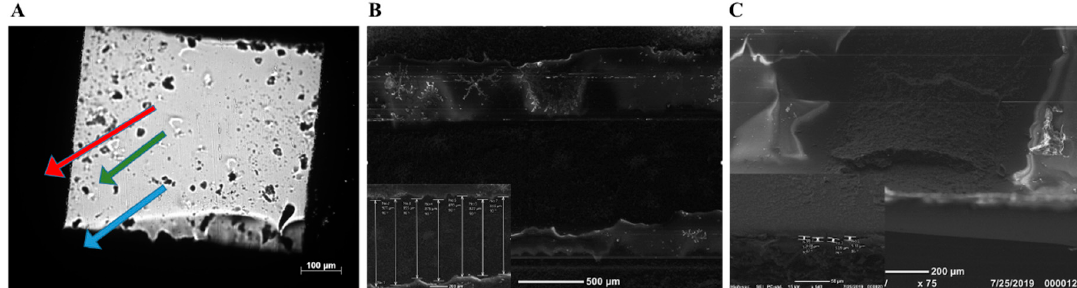
Figure 5. Microscope image of printing results. ( A ) An area of prints under the microscope. The red, blue, and green arrows indicate graphene, copper tape, and polyimide (PI), respectively, after the annealing process. ( B , C ) SEM images of printed graphene on PI using 2–5 kV accelerated voltage. ( B ) is a top-view image taken using SEM after annealing the prints with an average width of ≈ 868 µm. ( C ) shows an image of a cross section with an average depth of 5.20 µm.